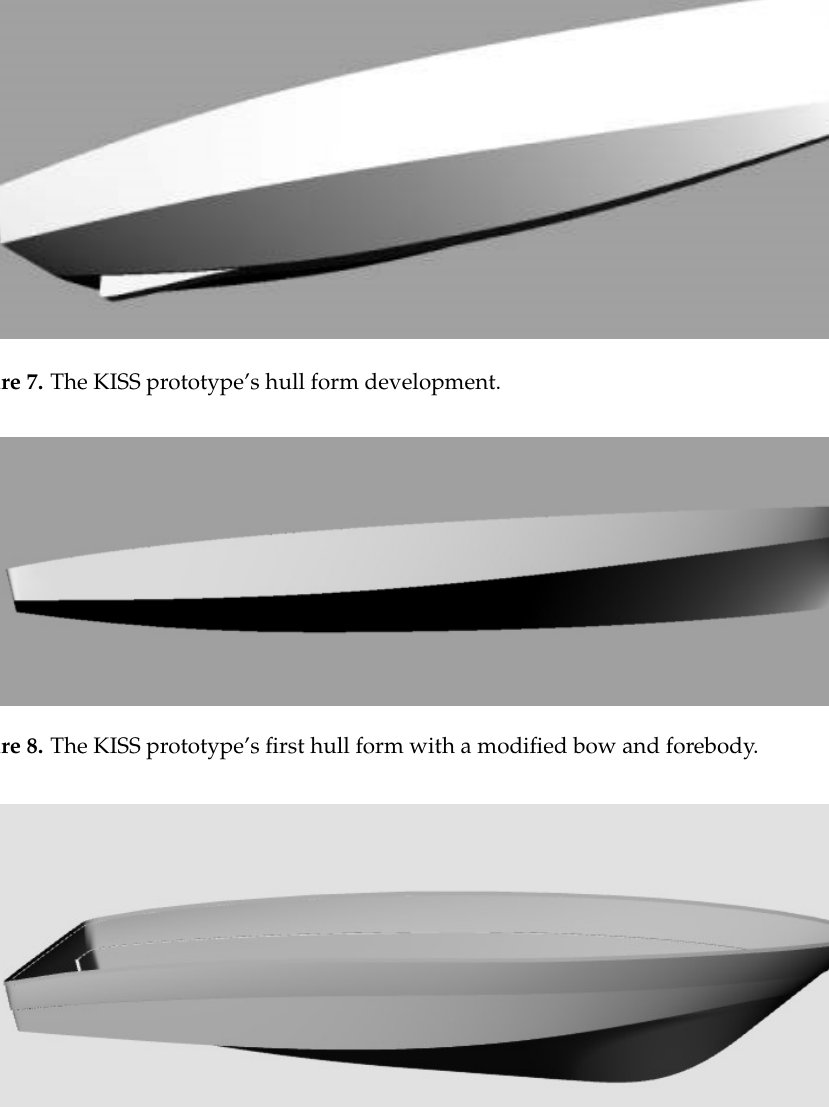
Figure 9. The final hull form of the KISS prototype.